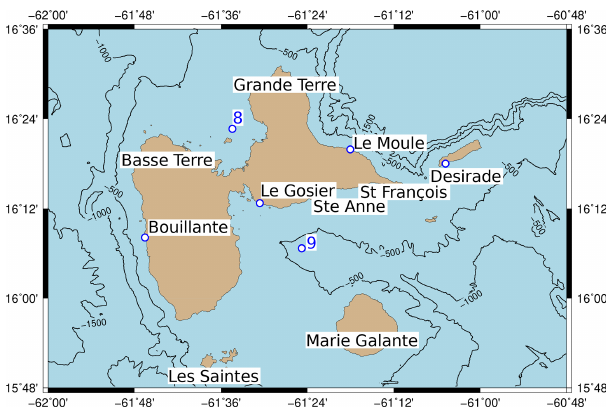
Figure 6. Guadeloupe archipelago and locations of gauges 8 and 9 and of the cities of Bouillante, Le Gosier, Le Moule and Desirade.